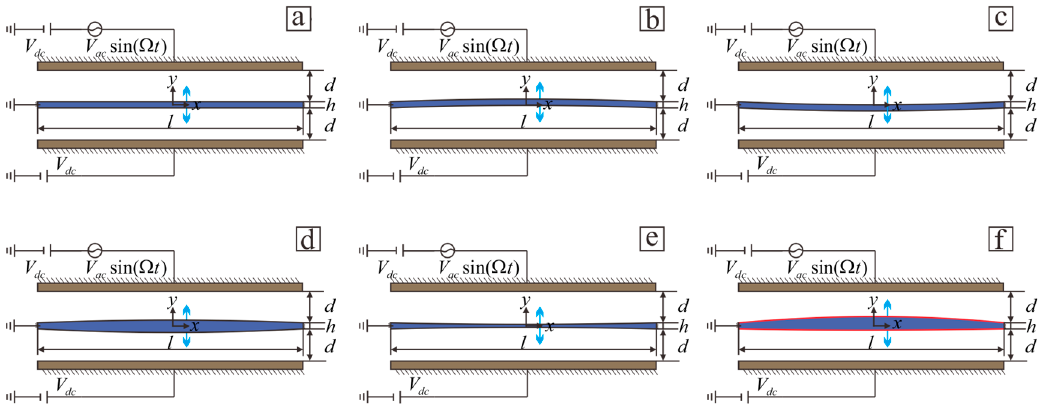
Figure 1. Schematic of an electrically actuated microbeam: ( a ) rectangular beam; ( b ) microbridge bending upward; ( c ) microbridge bending downward; ( d ) thickened microbeam; ( e ) thinned microbeam; ( f ) irregular beam.